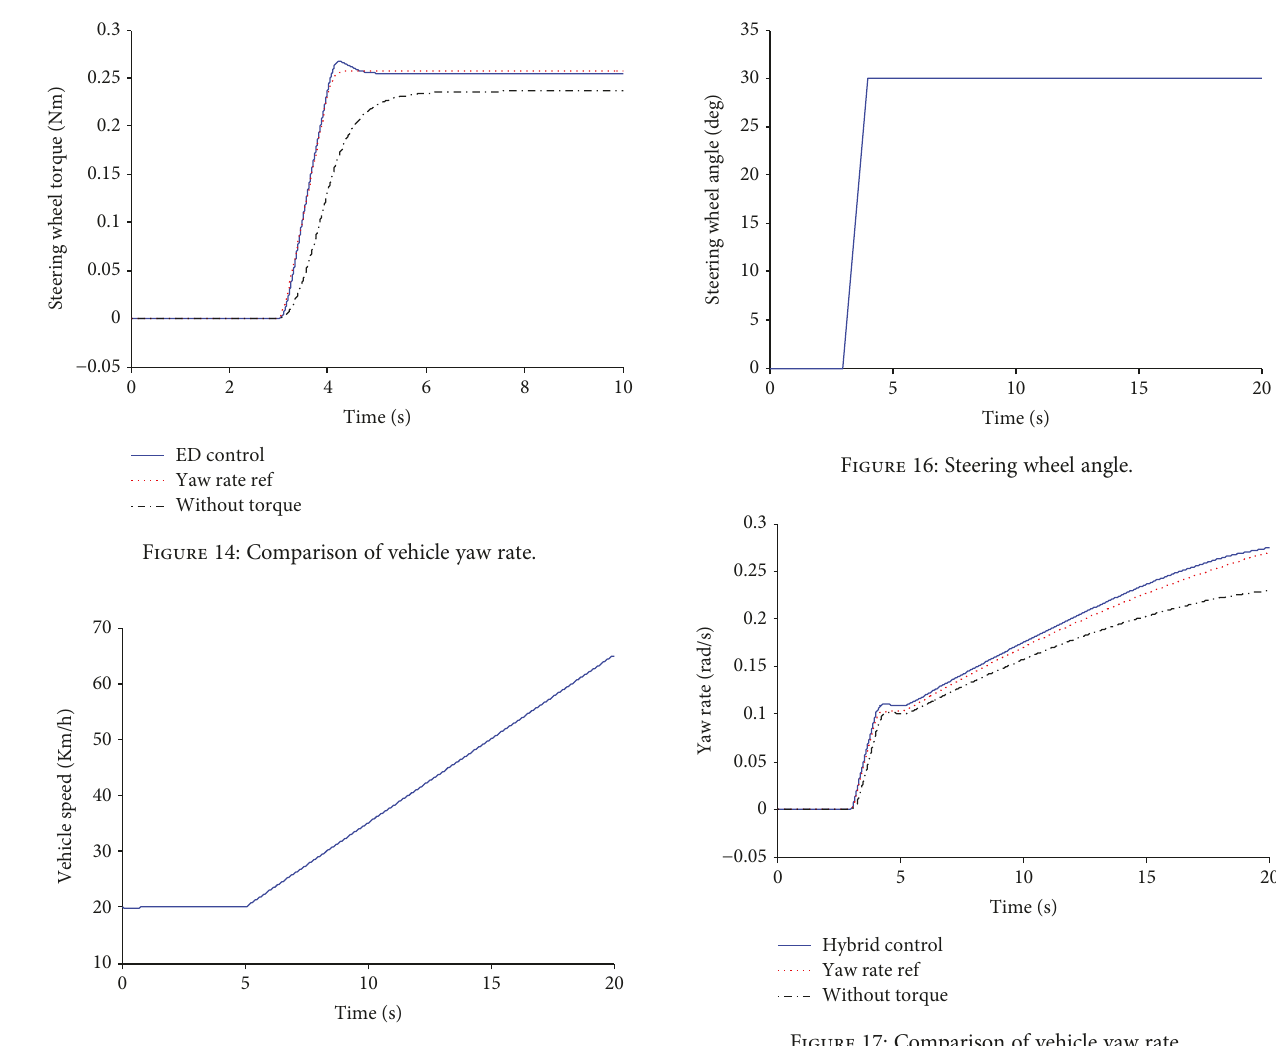
Figure 15: Vehicle speed of simulation.